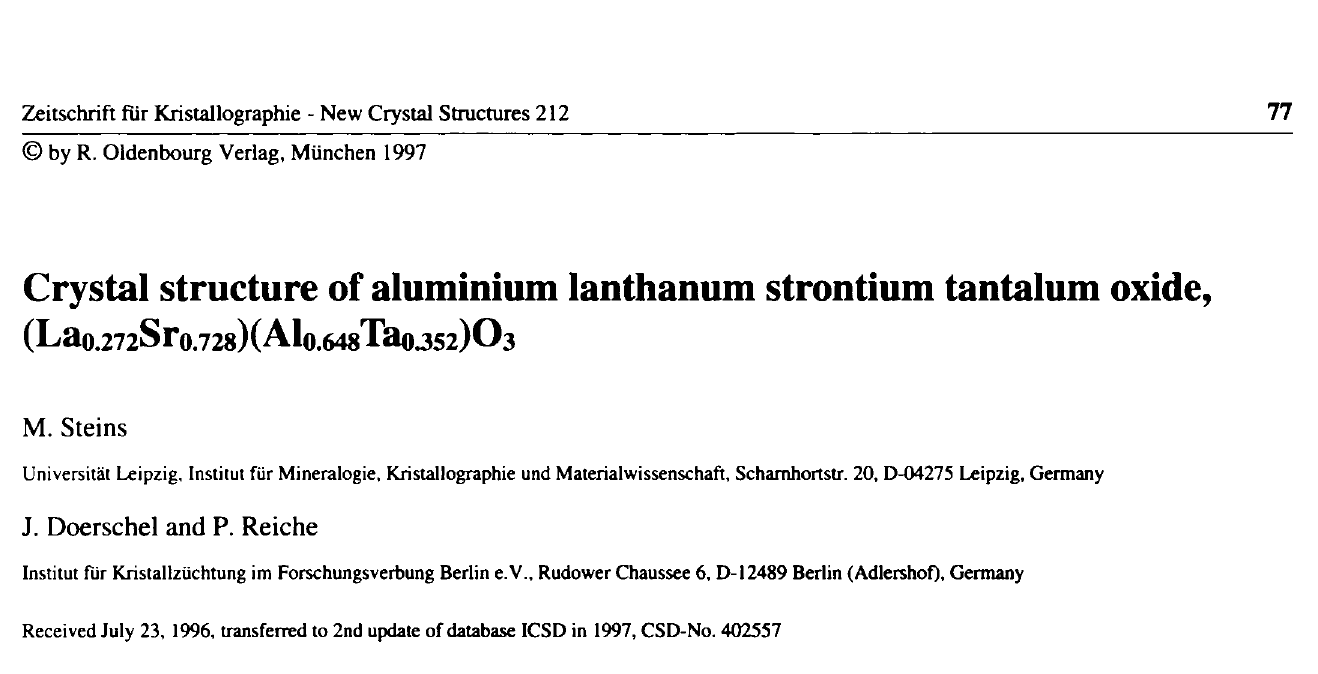
Table 1. Parameters used for the X-ray data collection Crystal: